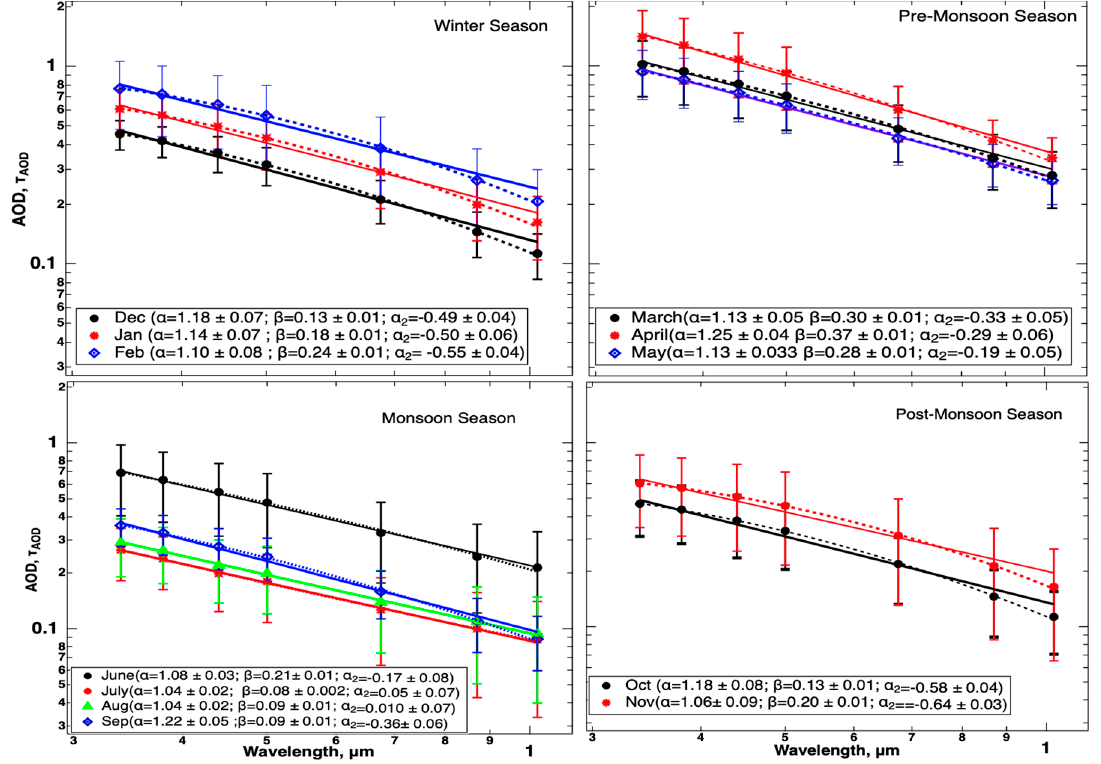
Figure 4. Ångström parameters ( α , β ) computed by using the linear regression (solid line), and α 2 from second-order polynomial fit (dotted curve) of monthly mean spectral AOD, between years 2010–2018, in the logarithmic scale for different seasons, as indicated.